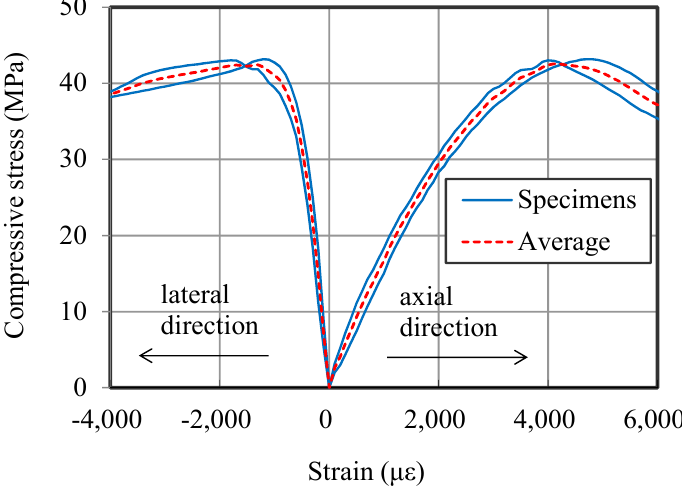
Figure 4. Compressive axial and lateral behavior of high-performance fiber-reinforced cement composite